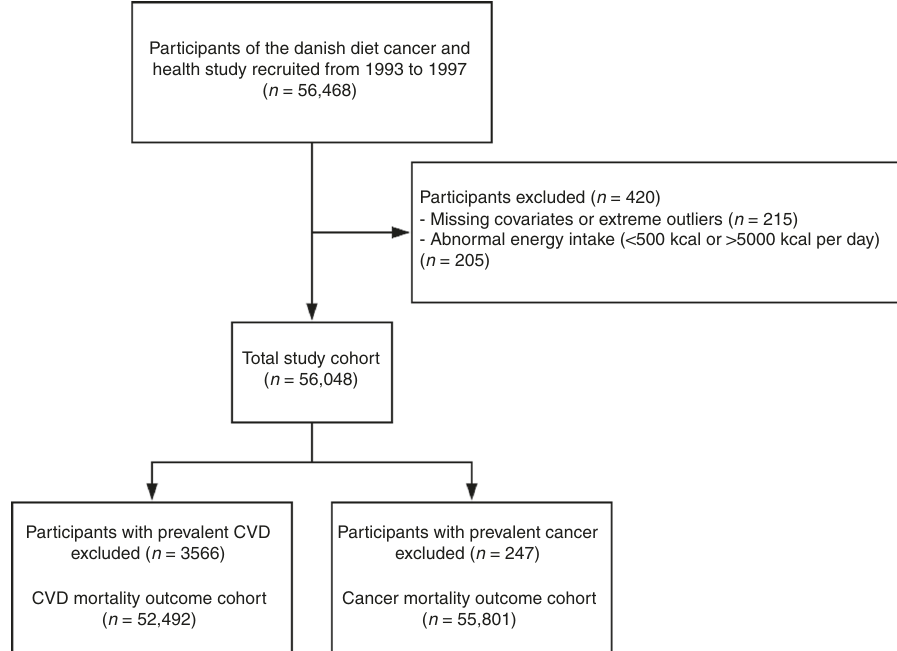
Fig. 4 Consort fl ow diagram. CVD cardiovascular